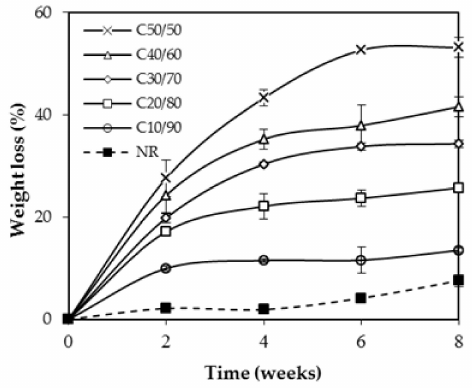
Figure 7. Biodegradation in soil of NR and MFC–NR composite